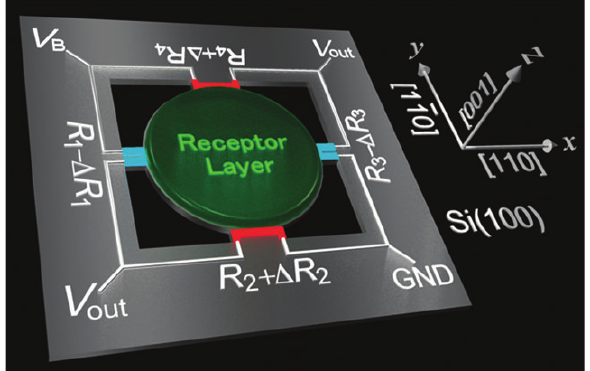
Figure 5 Schematic illustration of the membrane-type surface stress sensor with p-type piezoresistors on n-type single crystal Si(100). Reproduced with permission from Yoshikawa et al. (2011)